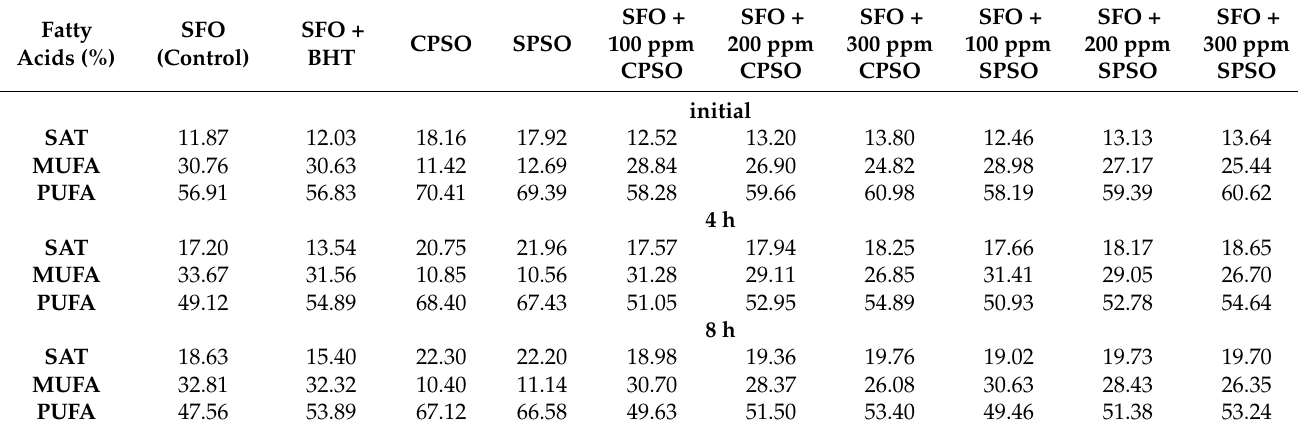
Table 3. The changes in fatty acid profiles of the oil samples in response to heating